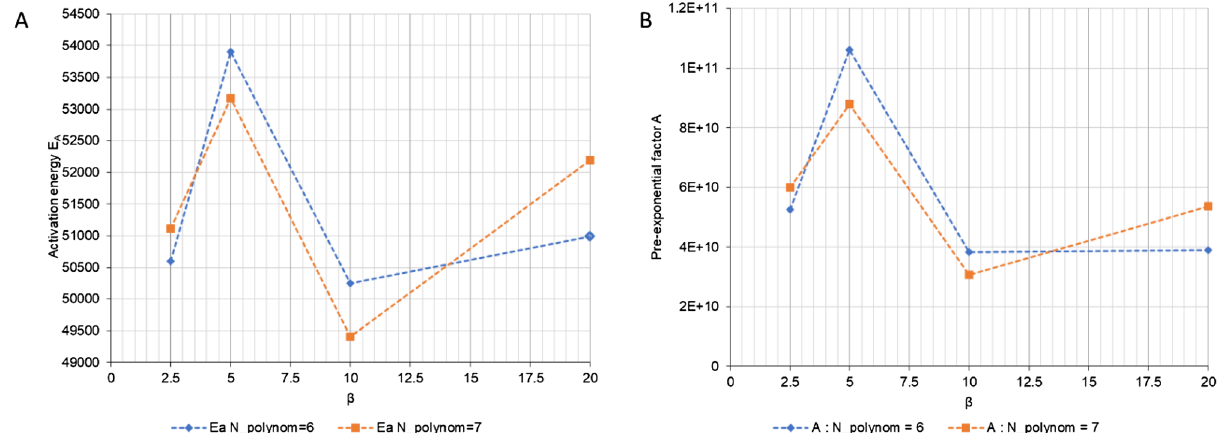
Figure 2. Influence of the degree of the polynomial equation on the graphs of activation energy ( A ) and the pre-exponential coefficient ( B ) as functions of heating rate.